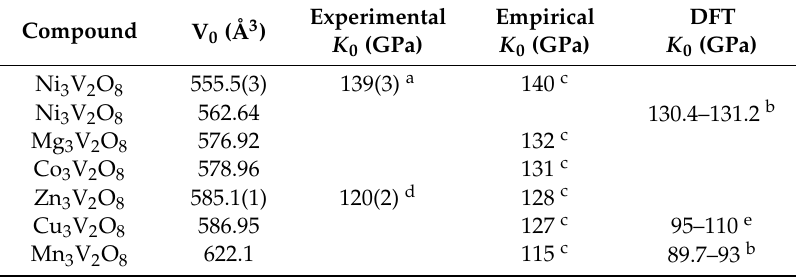
Table 3. Unit-cell volume, V 0 , and bulk modulus, K 0 , of di ff erent M 3 V 2 O 8 compounds. Compound V 0 (Å 3 )